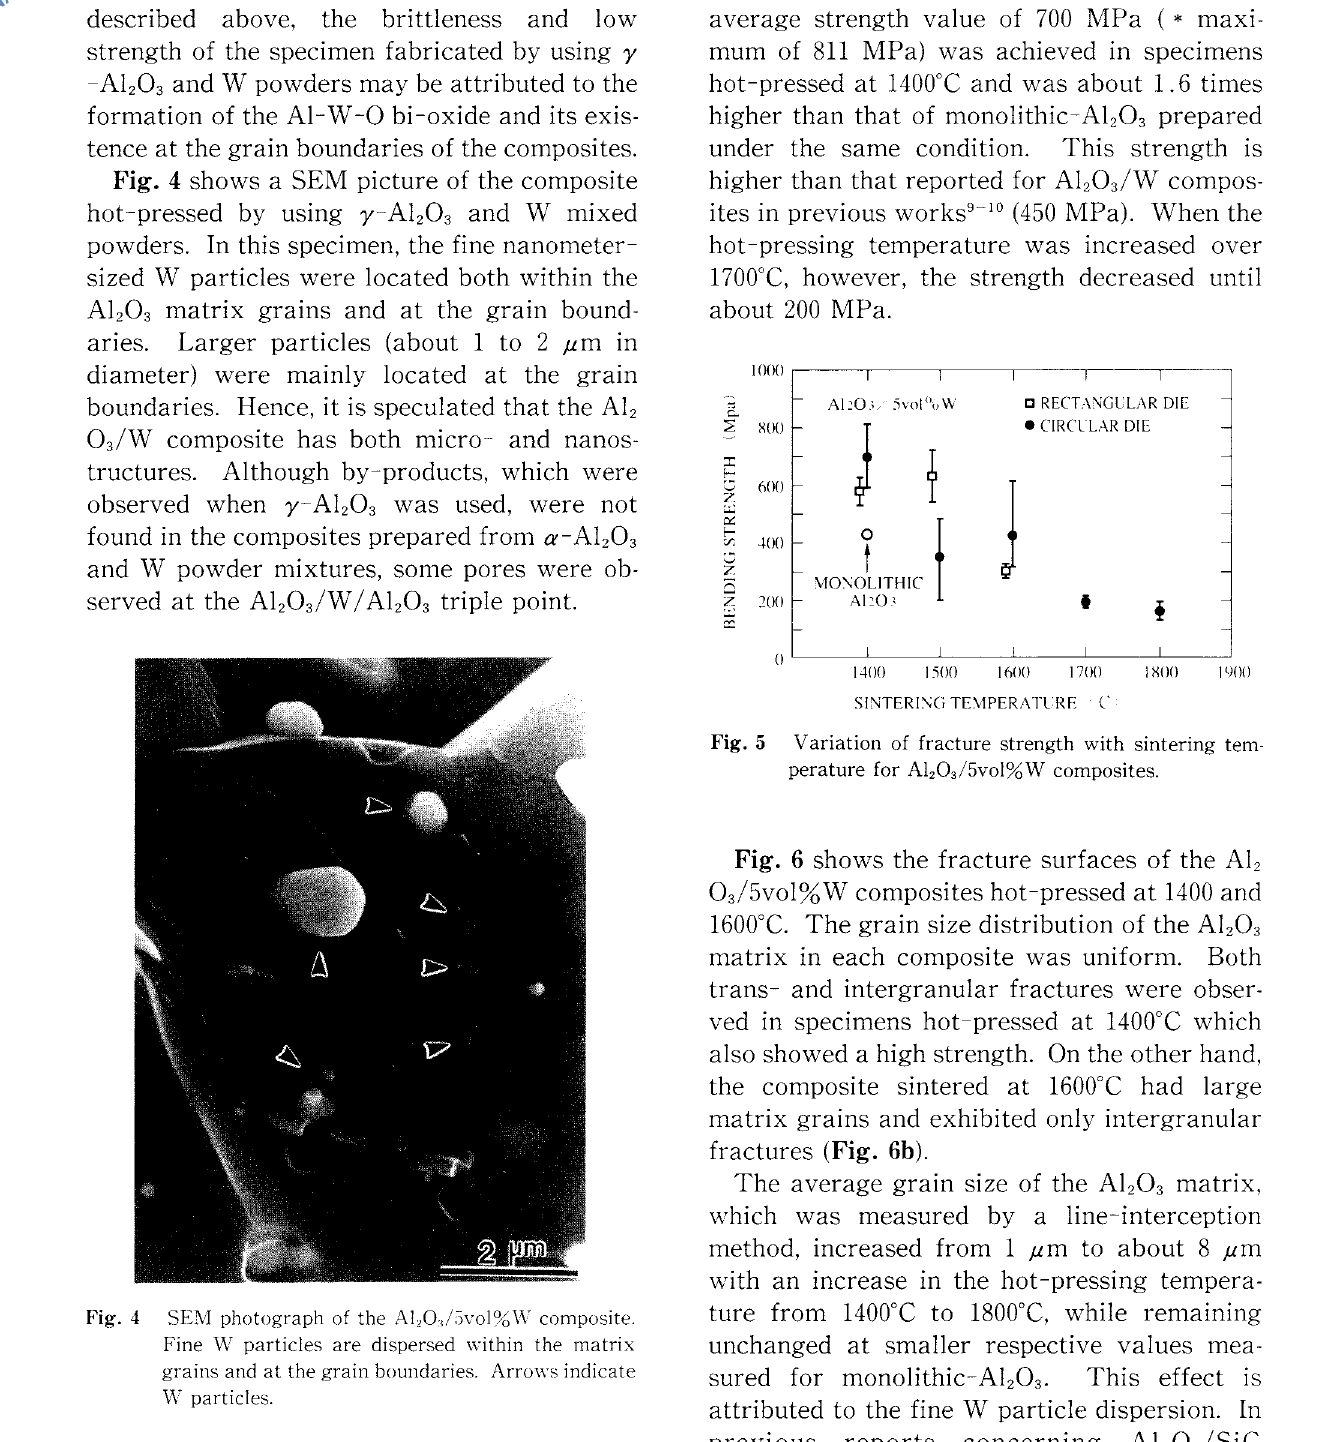
Fig. 4 SEM photograph of the Al,O,/;)\·ol%\\' composite. Fine \II,' particles are dispersed within the matrix grains and at the grain boundaries. Arrows indicate W particles.